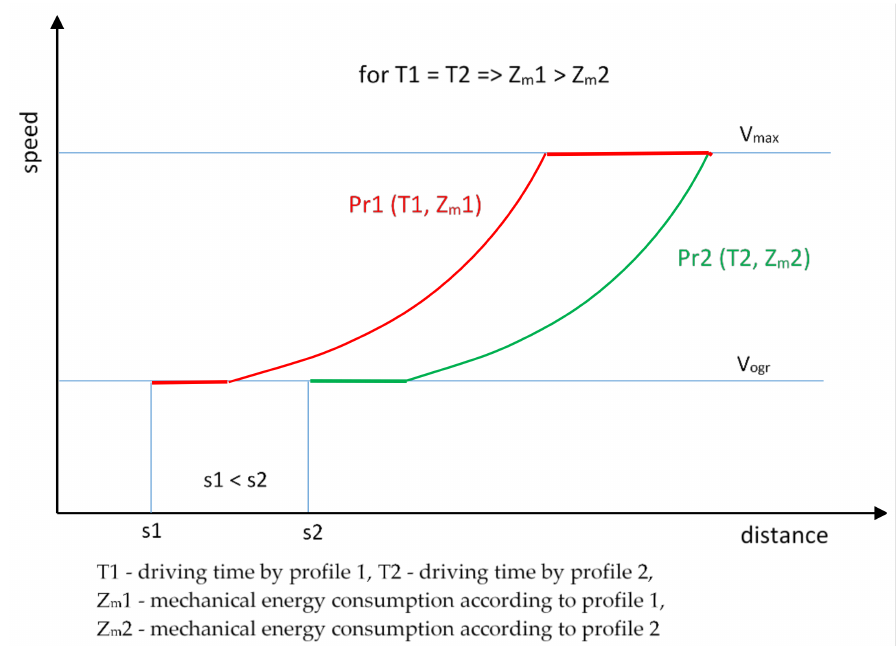
Figure 1. Consequence of loss of distance by the train (source: own elaboration).